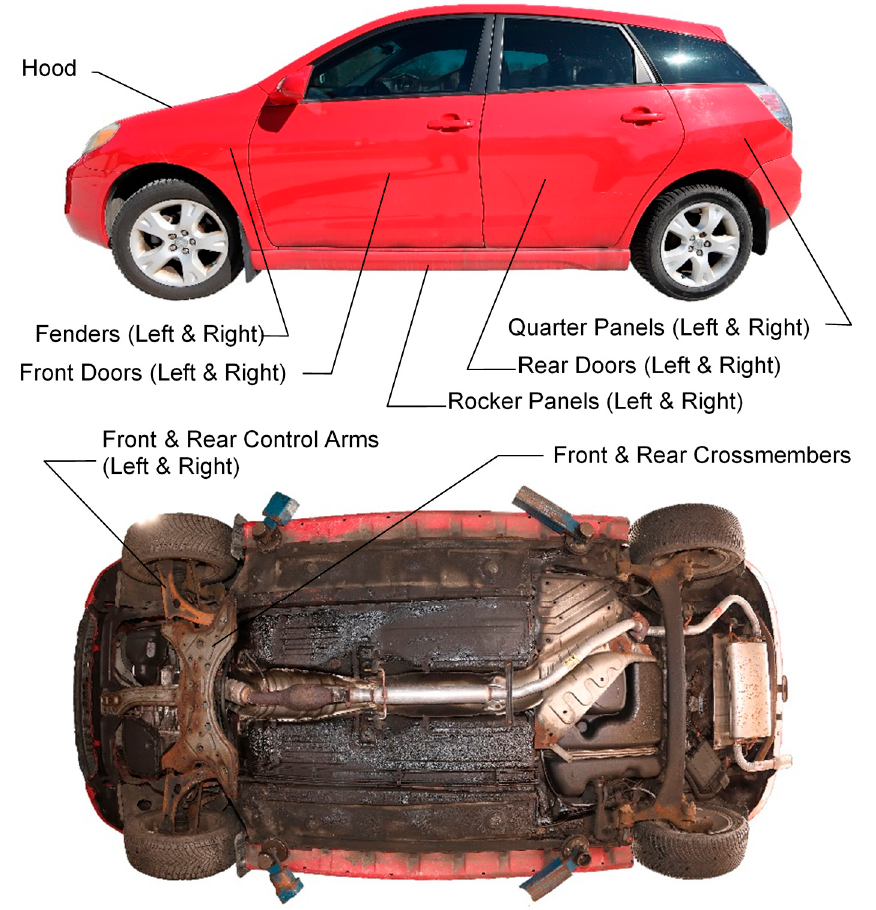
Figure 2. Corrosion-prone body panels and underbody parts used for corrosion study. Table 1. Targeted corrosion-prone part types used for corrosion assessment. Body Panels: